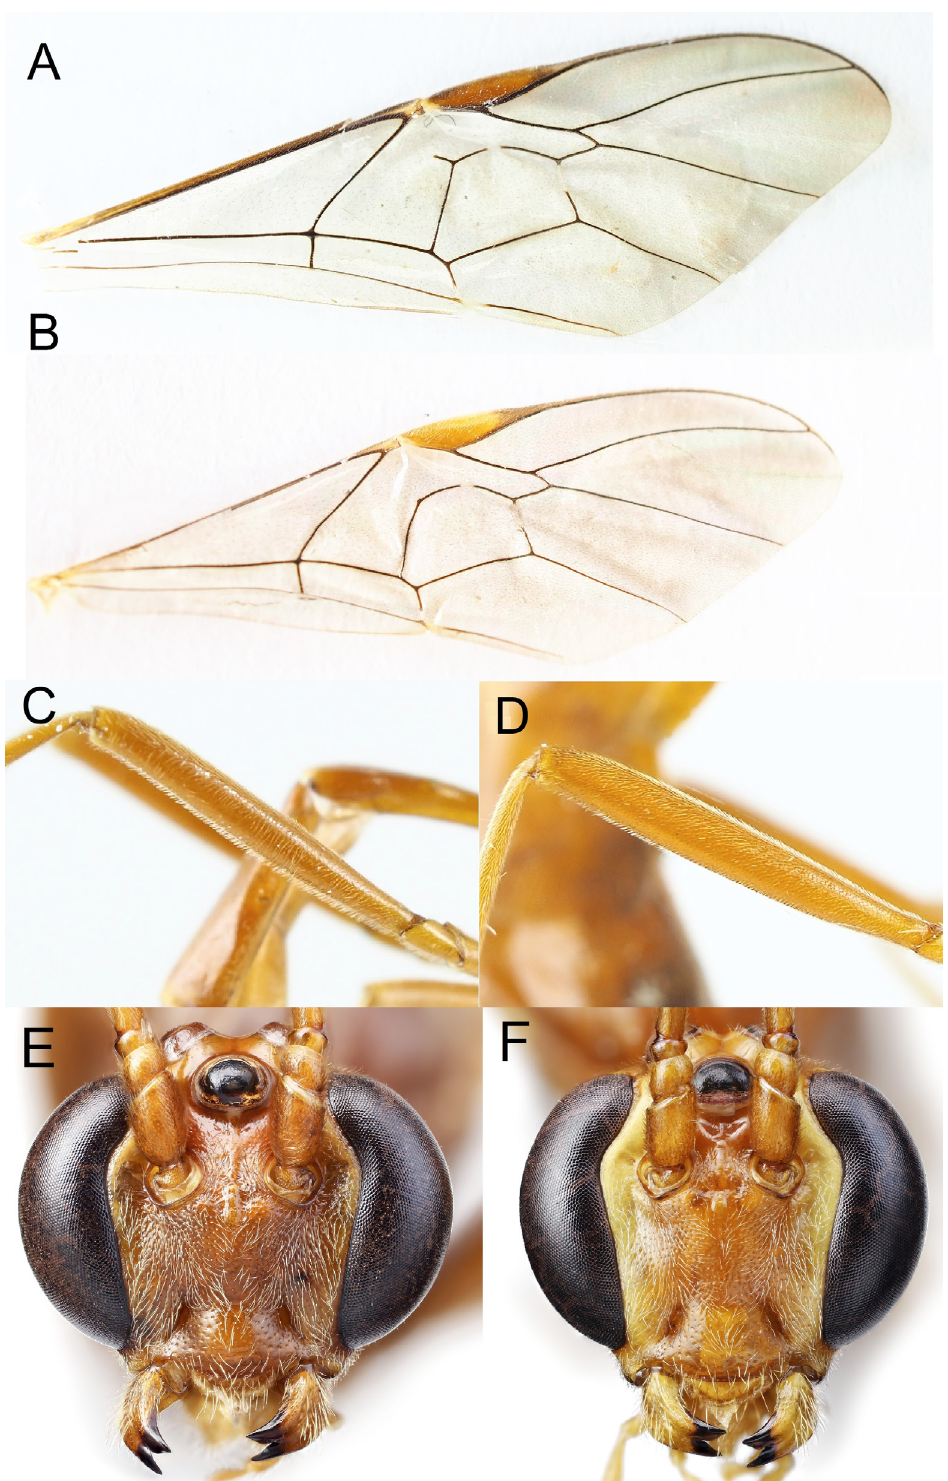
Fig. 16. A–B . right fore wing. A . Ophion scutellaris Thomson, 1888. B . O. wuestneii Kriechbaumer, 1882. C–D . right hind femur of female, lateral view. C . O. wuestneii . D . O. inclinans Johansson sp. nov., holotype, ♀ (NHRS-HEVA000008667). E–F . head, anterior view of female. E . Ophion kevoensis Jussila, 1965. F . Ophion broadi Johansson sp. nov. paratype, ♀